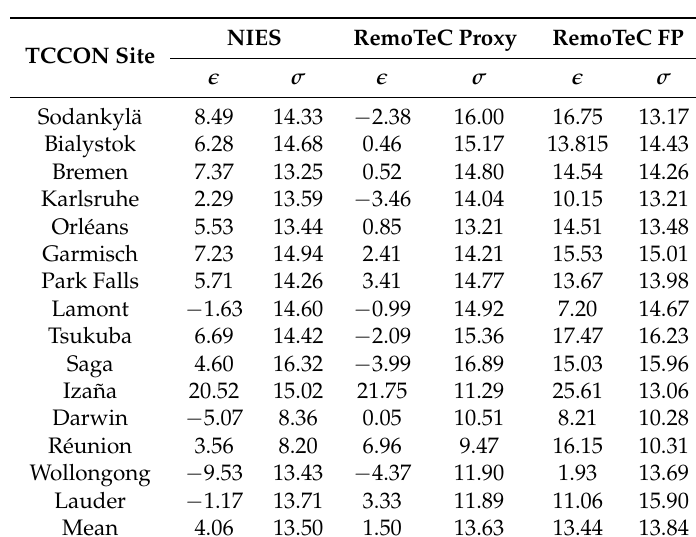
Table A1. Average biases ( (cid:101) , in ppb) and their standard deviations ( σ ) for GOSAT retrievals at the TCCON sites. Average biases, i.e., single-sounding errors, were calculated as an average from GOSAT-TCCON differences of individual soundings after averaging kernel